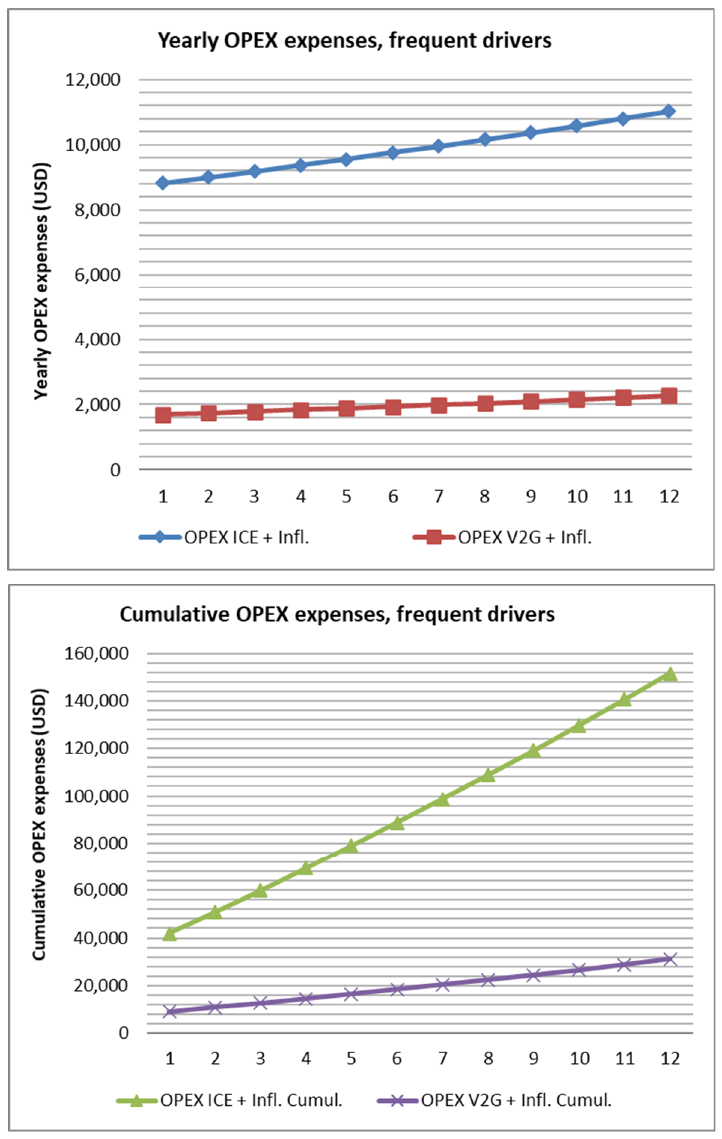
Figure 5. Comparison between yearly and cumulative OPEX expenses between an ICE vehicle and a V2G, frequent drivers.